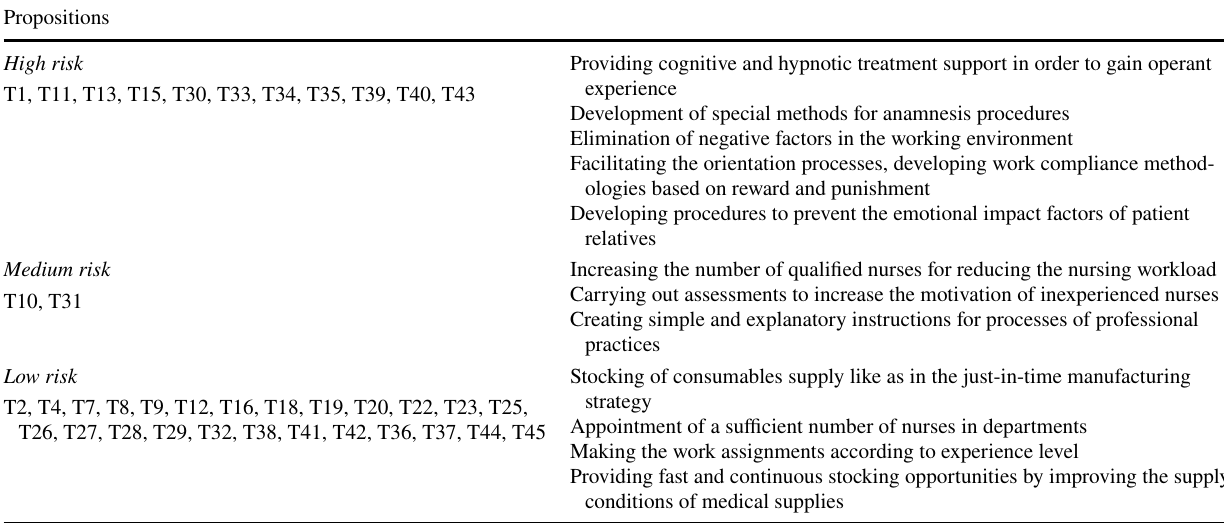
Table 12 Suggestive solutions with a view to risky tasks